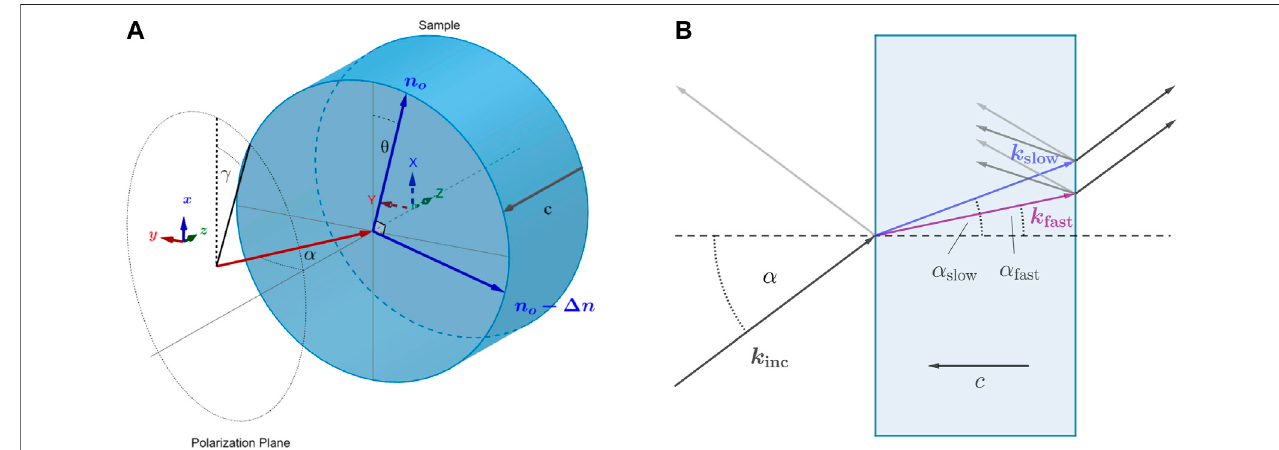
FIGURE 2 | (A) : reference-frame for the numerical tool. The ray (red) enters the sapphire sample with AOI = α in z-direction, while the orientation of the two separated axes perpendicular to the c-axis is given by θ . The input polarization is described with γ , governing the direction of the input electric- fi eld vector. The global reference direction is given by the x-axis. (B) : ray-doubling in birefringent